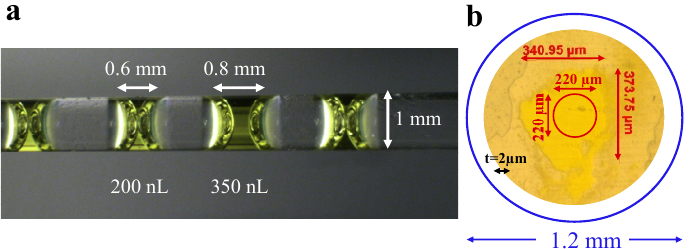
Figure 7. Protein samples prepared for time-resolved spectroscopic experiments. ( a ) Capillary containing multiple drops of PYP solution; four 200–400 nL drops of protein solution are mounted together; ( b ) PYP crystal crushed between two cover slides. The relative sizes of the laser pulse (blue) and the Xenon light source (red) are shown. The sample has a thickness (t) of approximately 2 μ